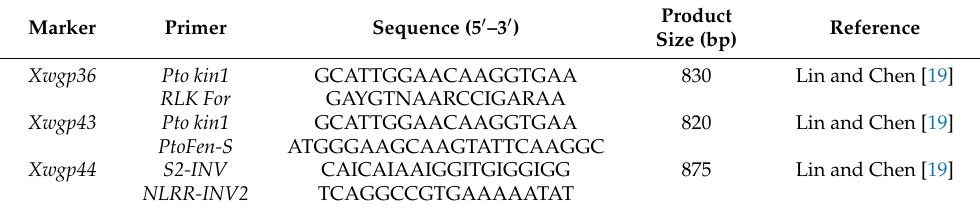
Table 1. Three RGAP primer sequences closely linked to wheat resistance to stripe rust gene Yr39 . Marker